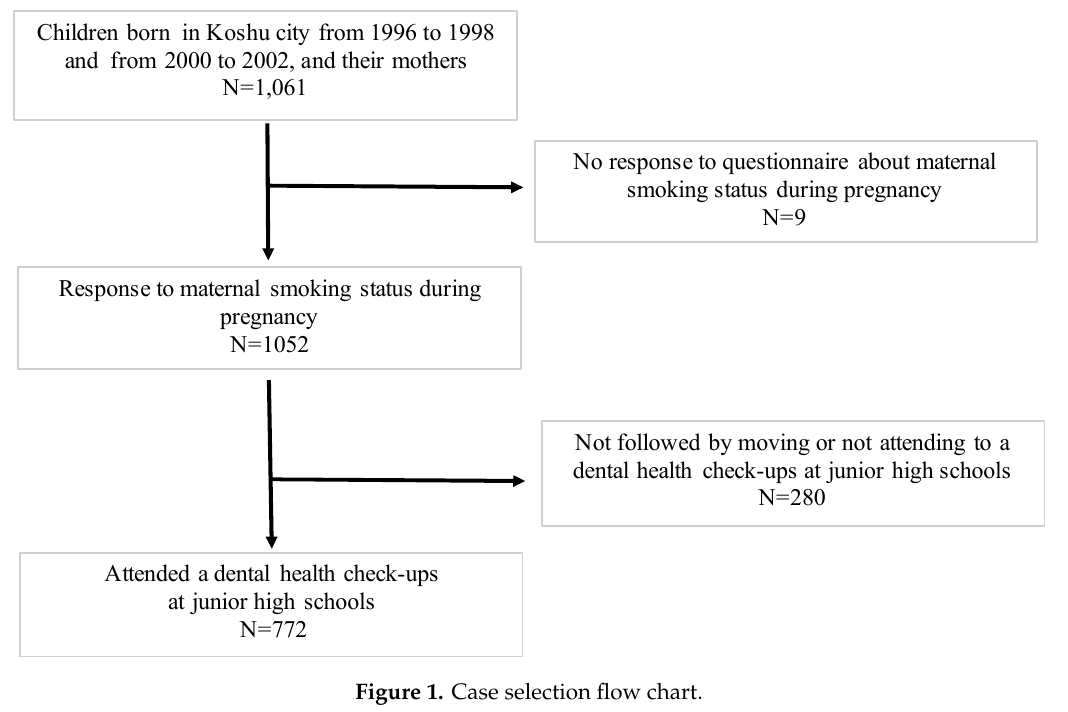
Figure 1. Case selection flow chart.